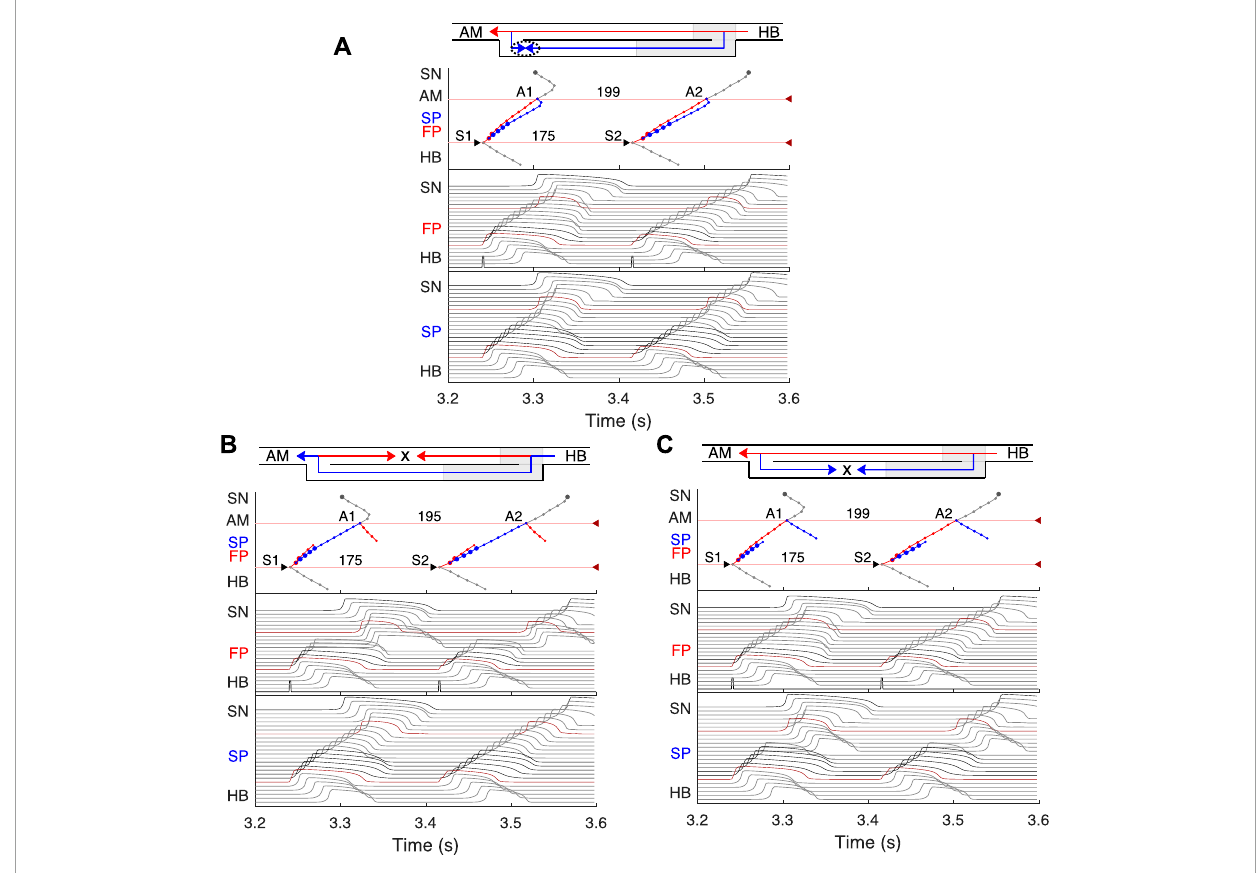
FIGURE 8 Retrograde AVN conduction, HB pacing with 175 ms S1S2 interval. (A) Control case. (B) After FP ablation. (C) After SP ablation. Upper and lower numbers correspond to A1A2 and S1S2 (H1H2) intervals. Short stimulation impulses are shown at the bottom of the middle